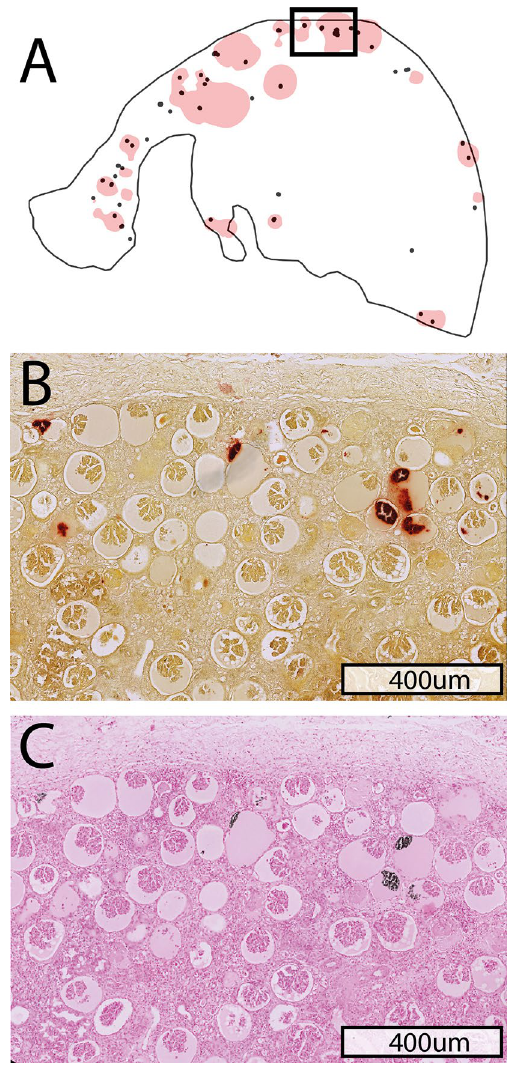
Figure 2. Overlay image of [ 18 F]-sodium fluoride ([ 18 F]-NaF) uptake and (Alizarin red) microcalcifications ( A ), with Alizarin red staining for microcalcifications ( B ) and Von Kossa staining for calcifications ( C